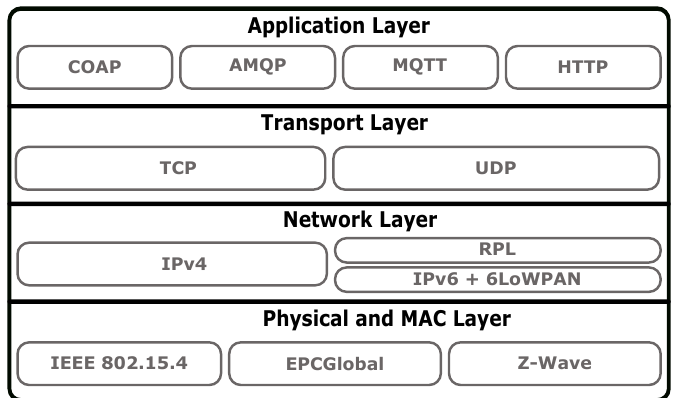
Figure 2. Popular IoT standards on an Internet Protocol (IP)-based solution (based on